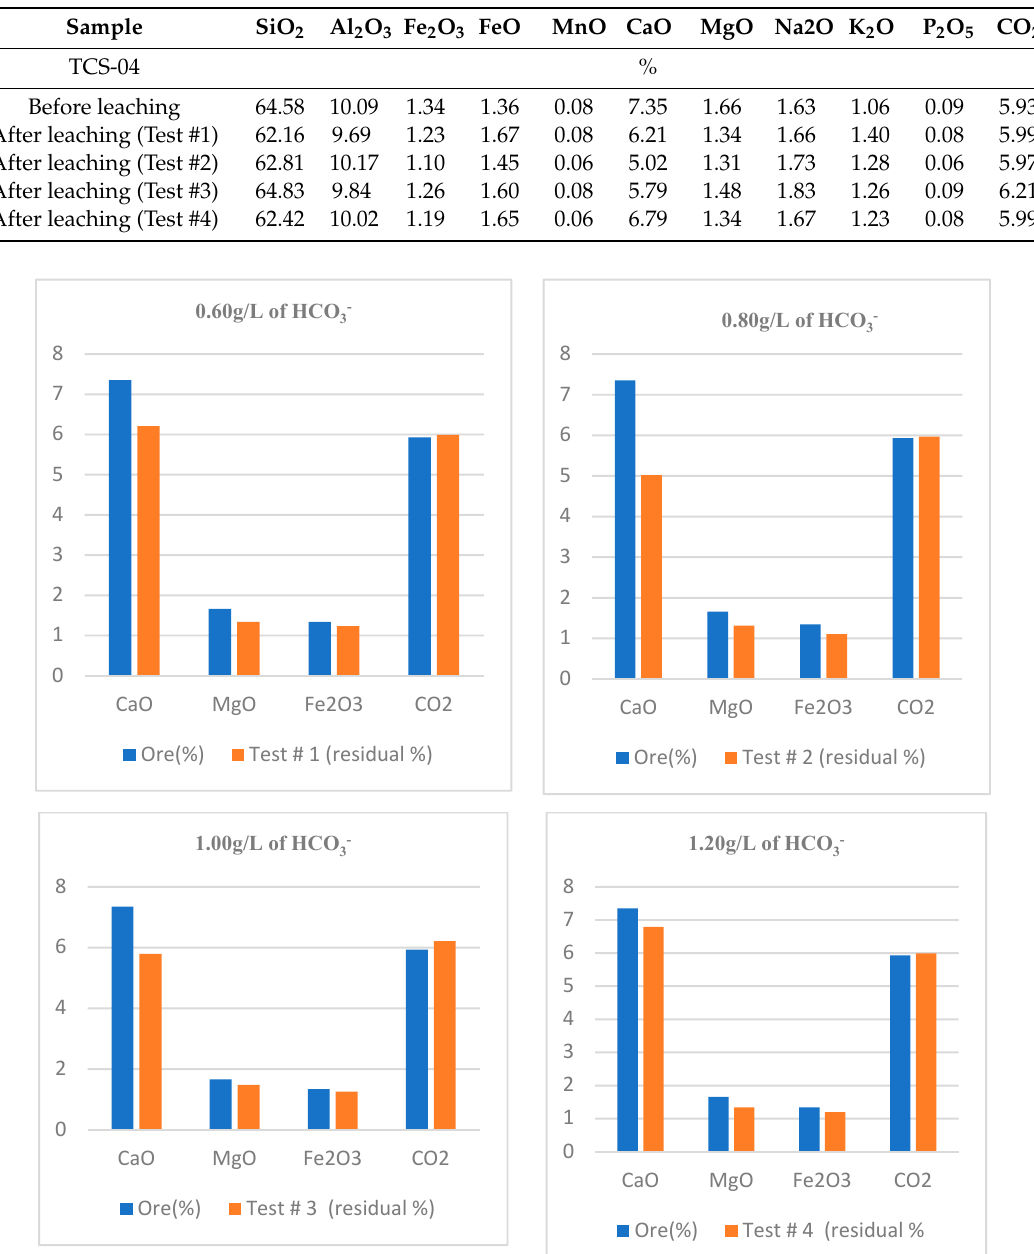
Figure 6. Concentration of oxides before and after leaching.